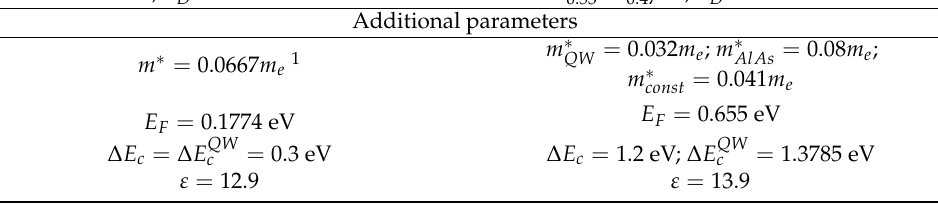
is postponed along the y